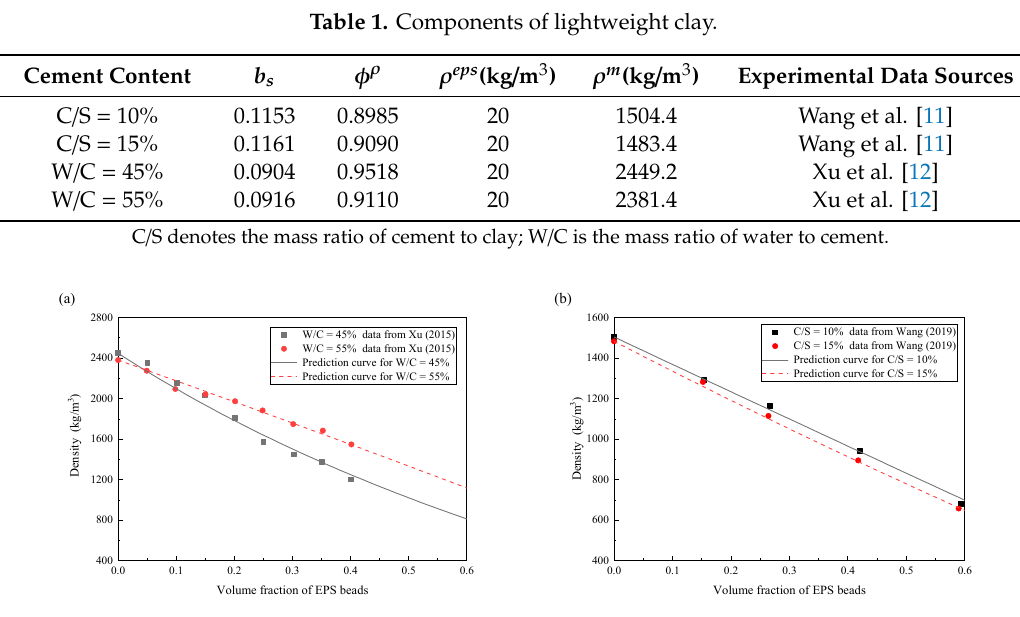
Figure 3. Density prediction ( a ) experimental data from Xu et al. [12]; ( b ) experimental data from Wang et al. [11].